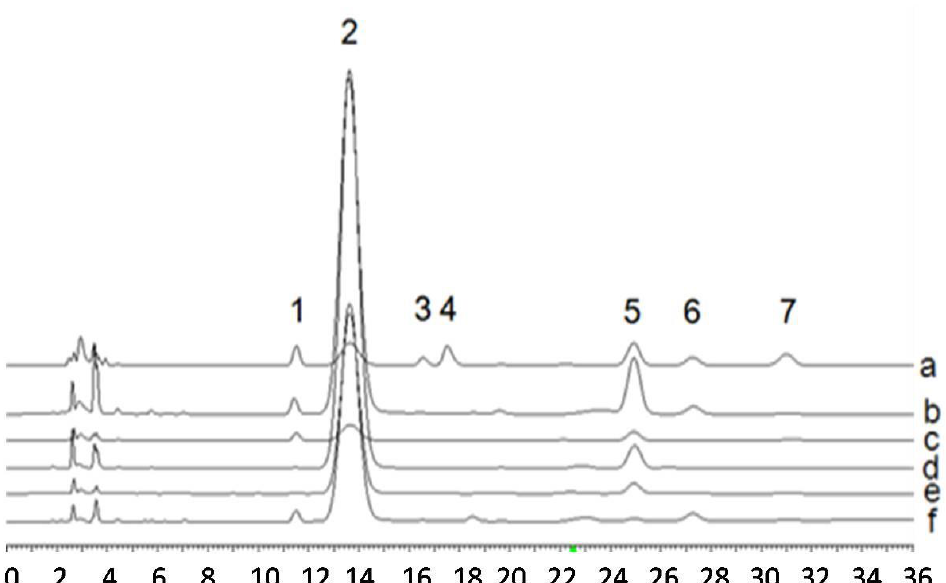
Figure 5. HPLC chromatograms of derivatized products of standard monosaccharide mixtures and the PMP derivatives of hydrolysis products of polysaccharides from P. cocos mycelia (M) or sclerotium (S). a: Standard monosaccharide mixture; b: APS (M); c: WPS (M); d: APS (S); e: WPS (S); f: EPS (M). Table 3. Regression equations and linear ranges for monosaccharides.